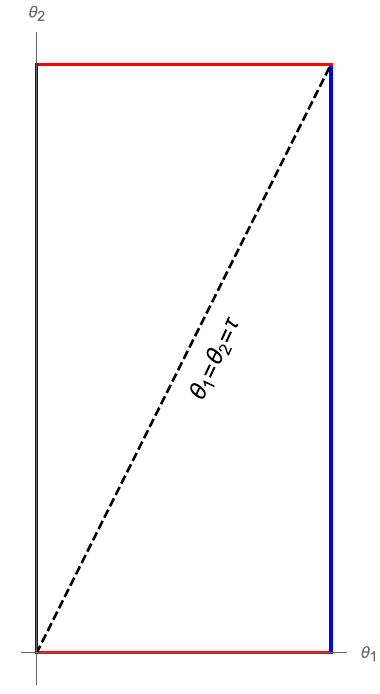
Fig. 7 Topological representation of the torus. The red and blue lines are identified. The diagonal dashed line represents a circle on the torus